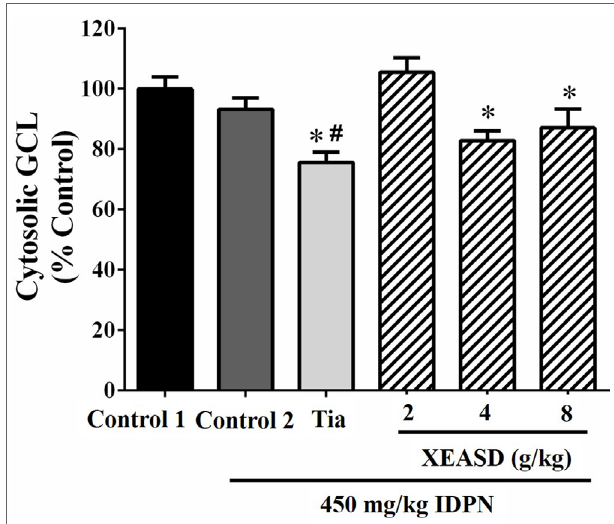
FIGURE 8 | Effects of XEASD treatment on brain cytosolic GCL activity in IDPN-induced TS mice. Biochemical assay of cytosolic GCL activity was performed as described in Materials and Methods. Control 1 represents normal control mice; control 2 represents IDPN-challenged control mice. Data are expressed as the percentage of non-challenged control 1 values. * P < 0.05, significantly different from the control 1; # P < 0.05, significantly different from the IDPN control 2. The value of GCL activity of control 1 (mean ± S.E.M). was 73.4 ± 5.29 (mU/mg